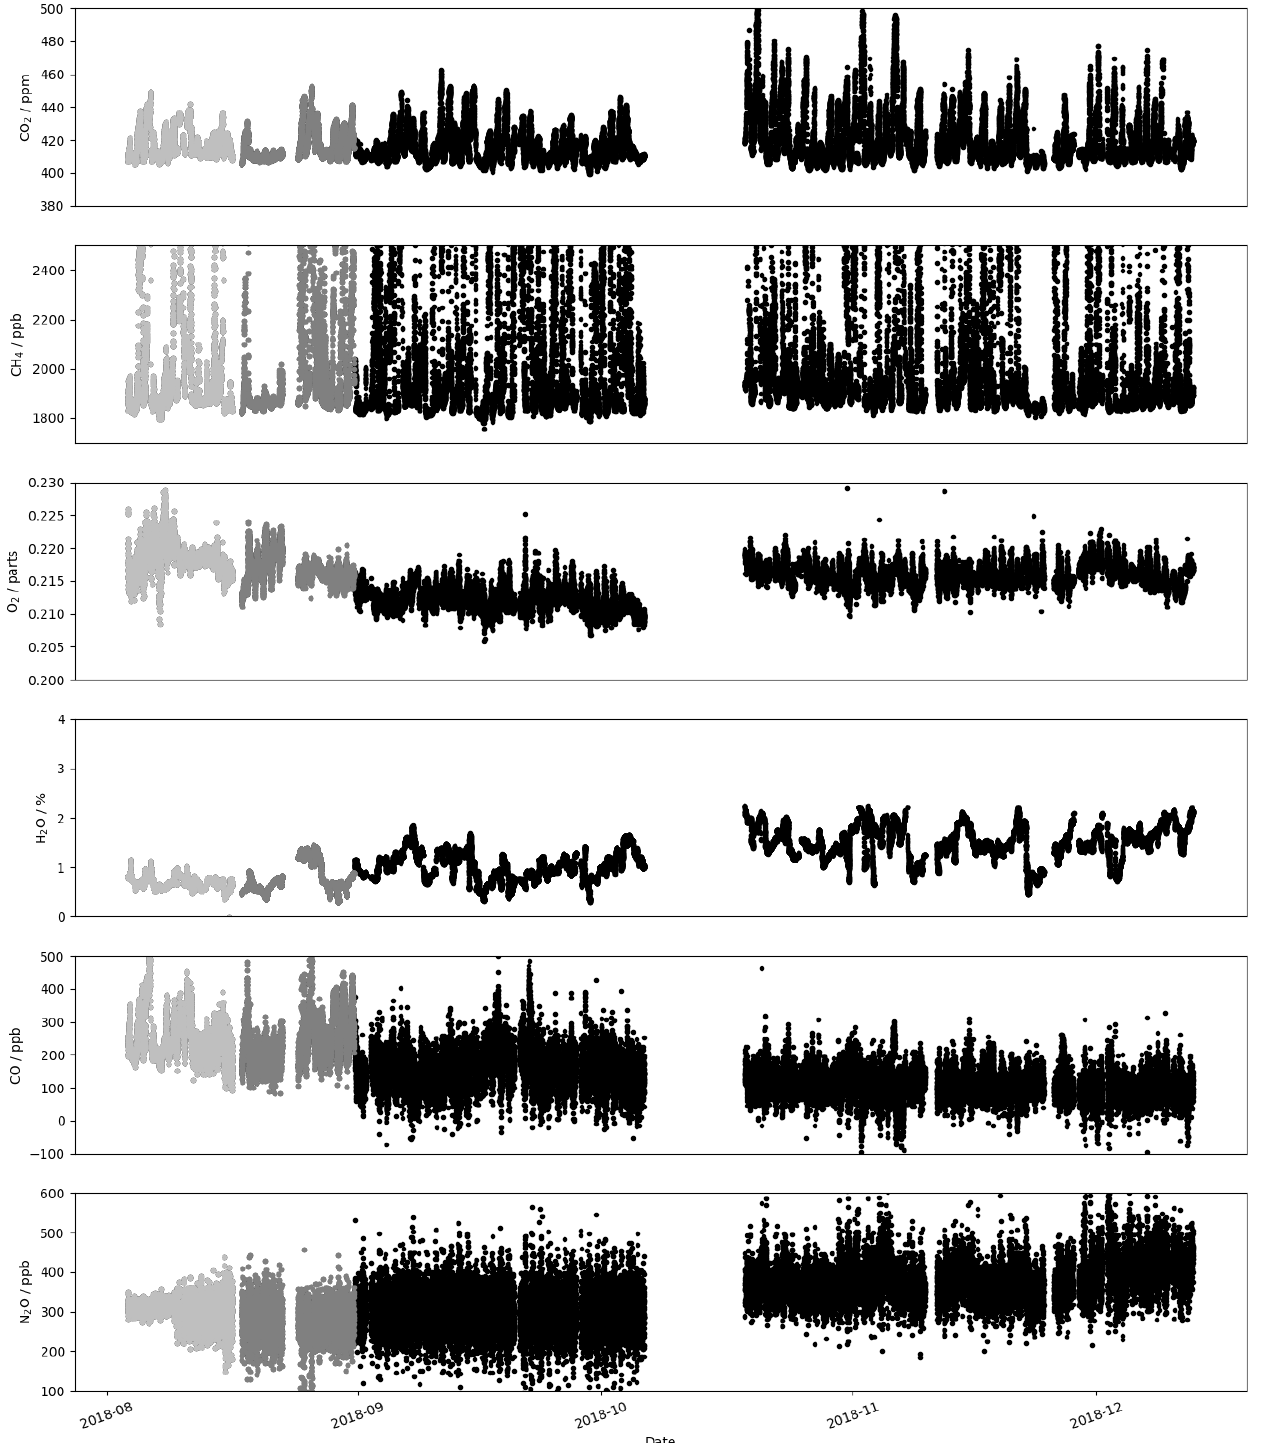
Figure 5. Time series of the retrieved path-averaged mole fractions for the 600, 1110 and 1500m path lengths. Data collected at a one-way path length of 600m are shown in light grey, at 1110m in darker grey, and the 1500m path length in black. The CH 4 y axis has been zoomed to 1700 to 2500nmolmol − 1